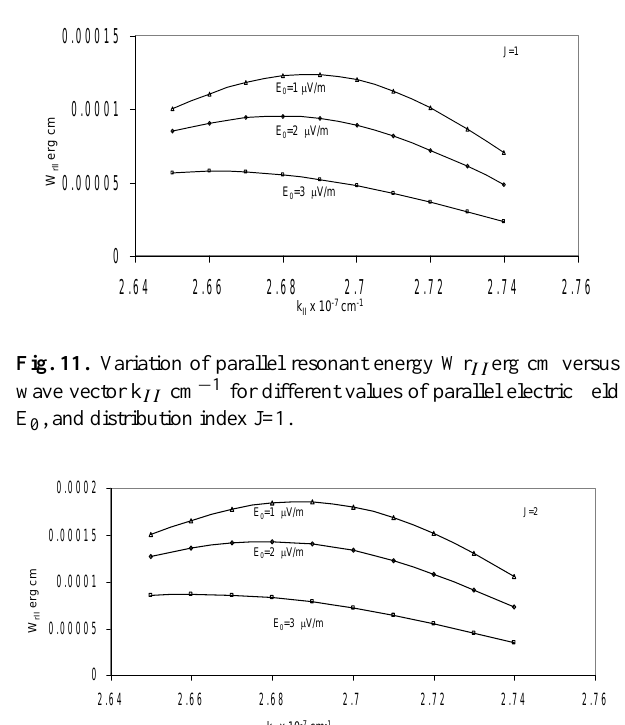
Fig. 12. Variation of parallel resonant energy Wr II ergcm versus Fig. 12 Variation of parallel resonant energy Wr II erg cm versus wave vector k II cm-1for different values of Fig:-9 Variation of parallel resonant energy W rII erg versus wave vec tor k II cm for differentvalues of parallel electric field E 0 ,and -1 wave vector k II cm − 1 for different values of parallel electric field parallel electric field E 0 , and distribution index J = 2. distribution index J=2. E 0 , and distribution index